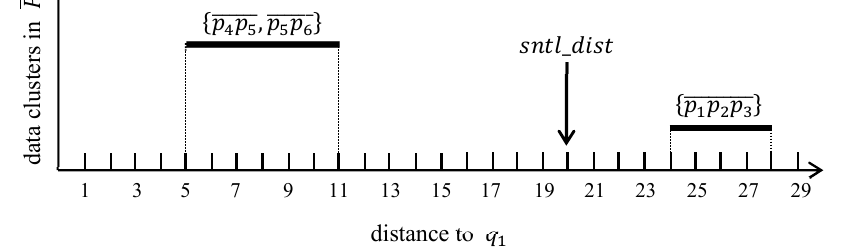
Figure 11. Arranging data clusters in decreasing order of their maximum distance to q 1